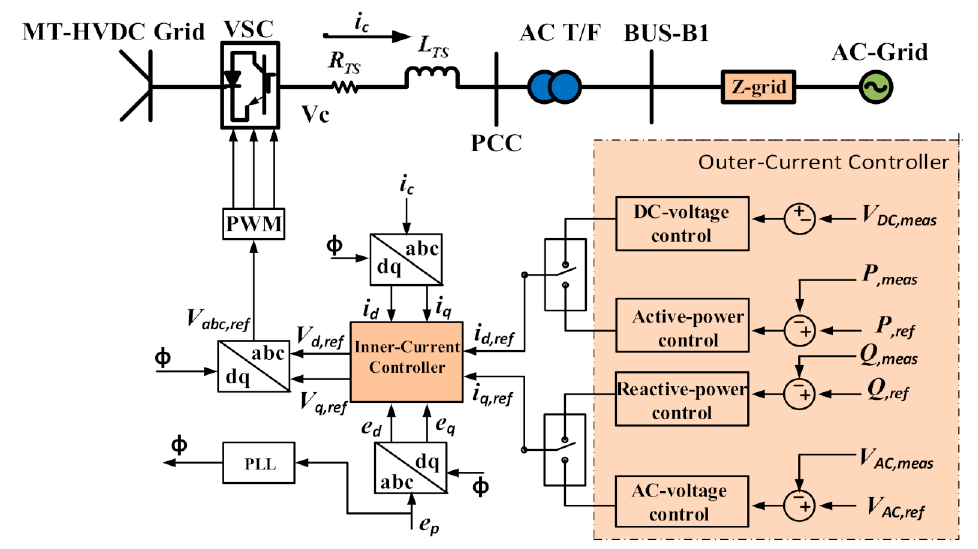
Figure 2. Single line diagram of d-q vector-control for the VSC-based MT-HVDC